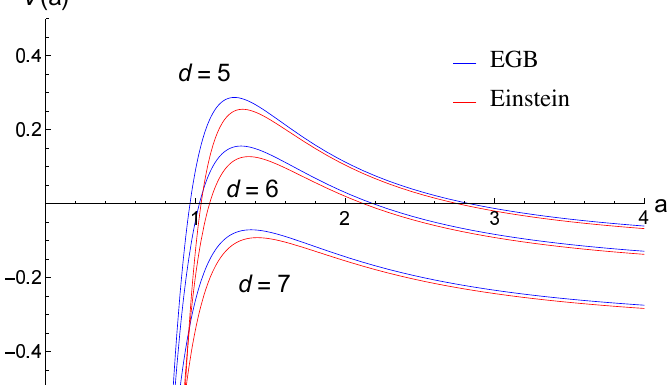
Figure 17. The potential ¯ V ( a ) for d = 5,6,7 in Einstein and Einstein–Gauss–Bonnet (EGB) gravity with k = 1, α = 0.02, m = 1, Λ = 1 and σ = − 0.1.